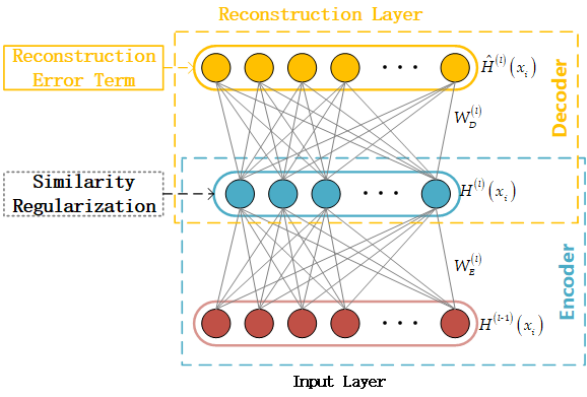
Figure 4. Illustration of the l th AE training in stage 1. The AP-SAE can be optimized layer-wisely by minimizing the reconstruction error of AE with similarity